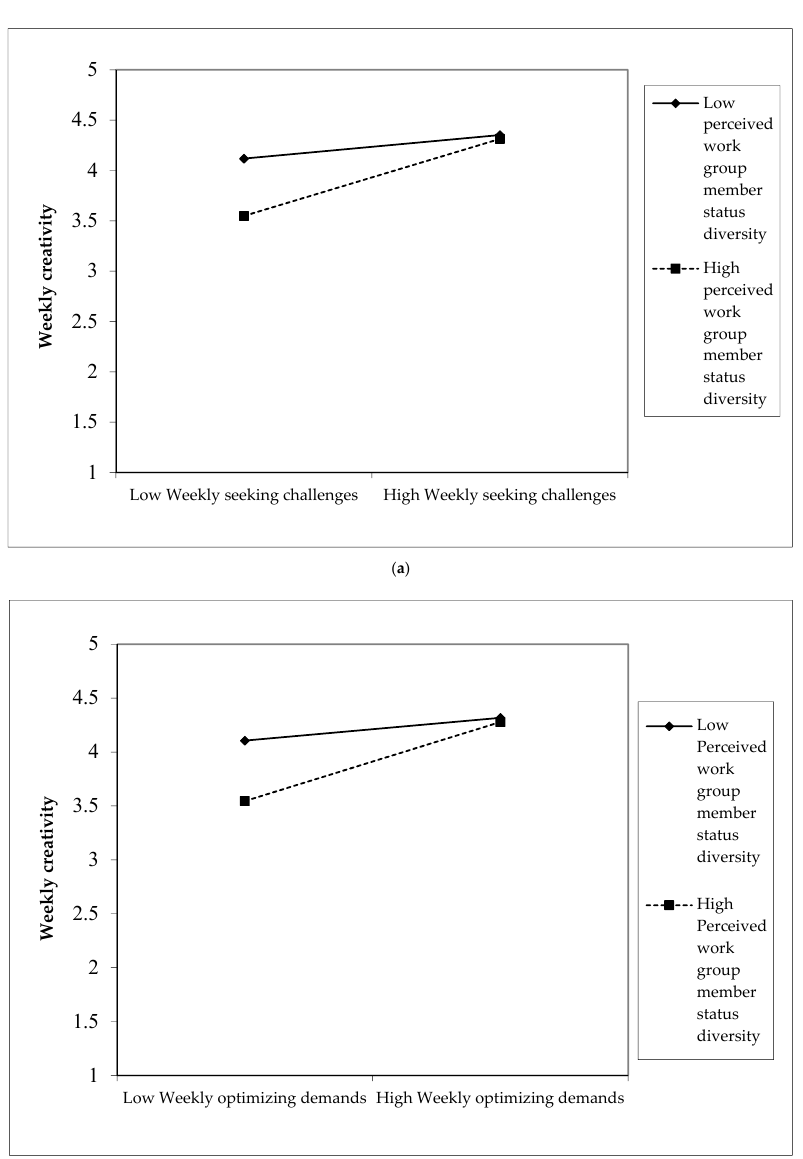
Figure 2. ( a ) The interaction of perceived work group status diversity and weekly seeking challenges on weekly creativity, ( b ) the interaction of perceived work group status diversity and weekly optimizing demands on weekly creativity.